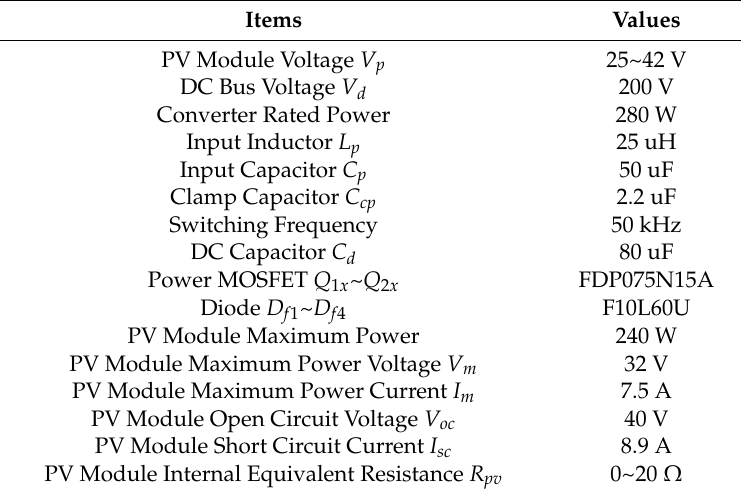
Table 2. Parameters of DC-DC